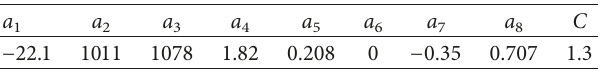
Table 1: Magic formula tire model parameters